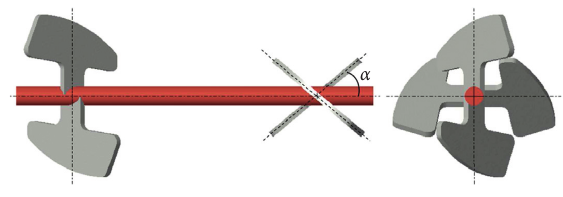
Figure 17: The initial model of the stirring